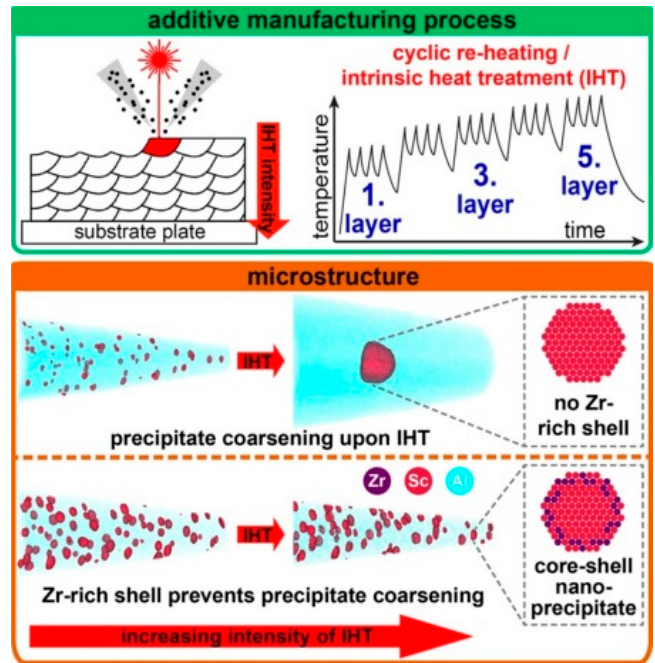
Figure 29. Control of thermally stable core − shell nanoprecipitates in additively manufactured Al − Sc − Zr alloys [138].